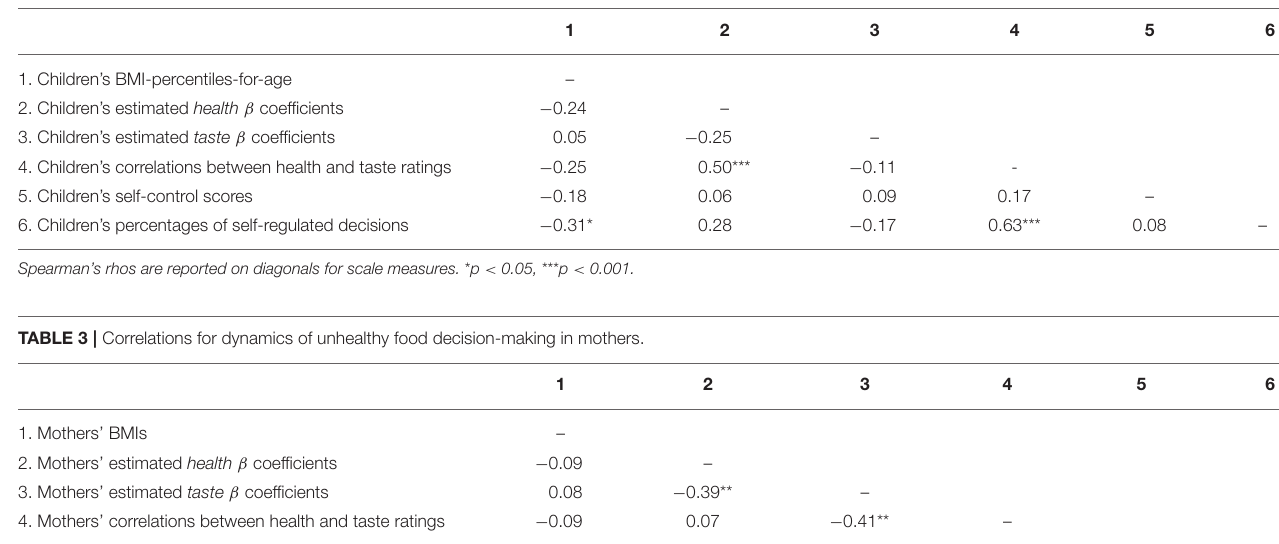
TABLE 2 | Correlations for dynamics of unhealthy food decision-making in children.